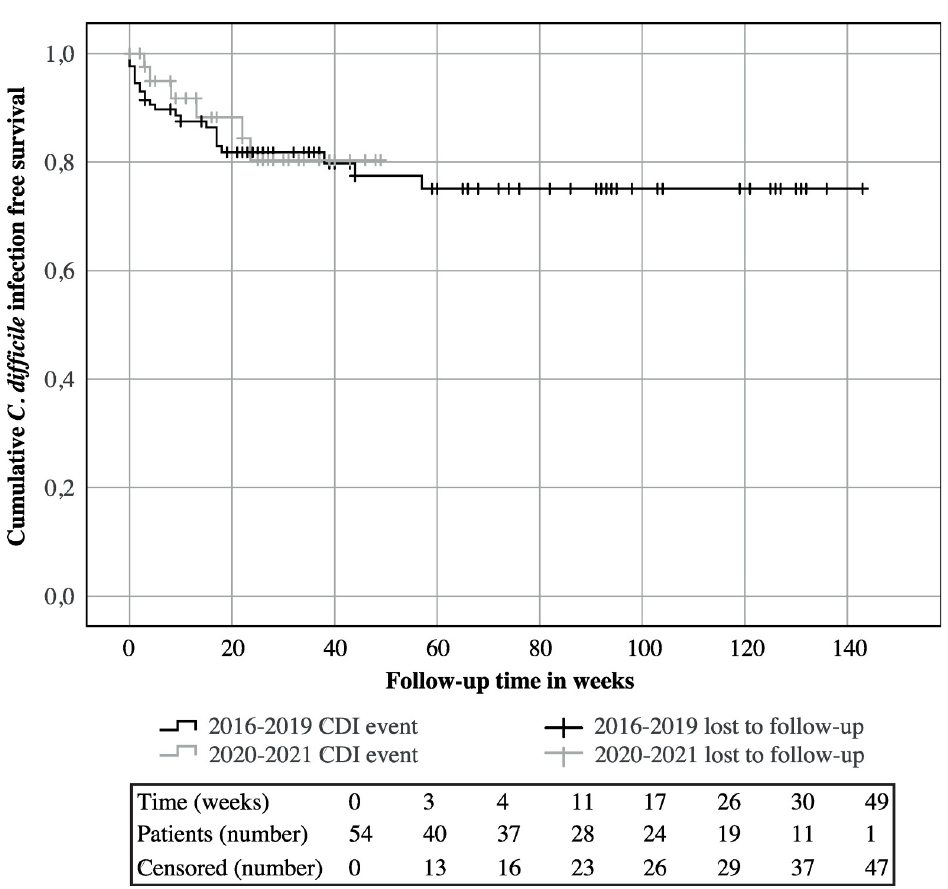
Fig 2. Clostridioides difficile infection-free survival during versus before the COVID-19 pandemic. Kaplan Meier curve of Clostridioides difficile infection-free survival pre (2016–2019) and during the COVID-19 pandemic